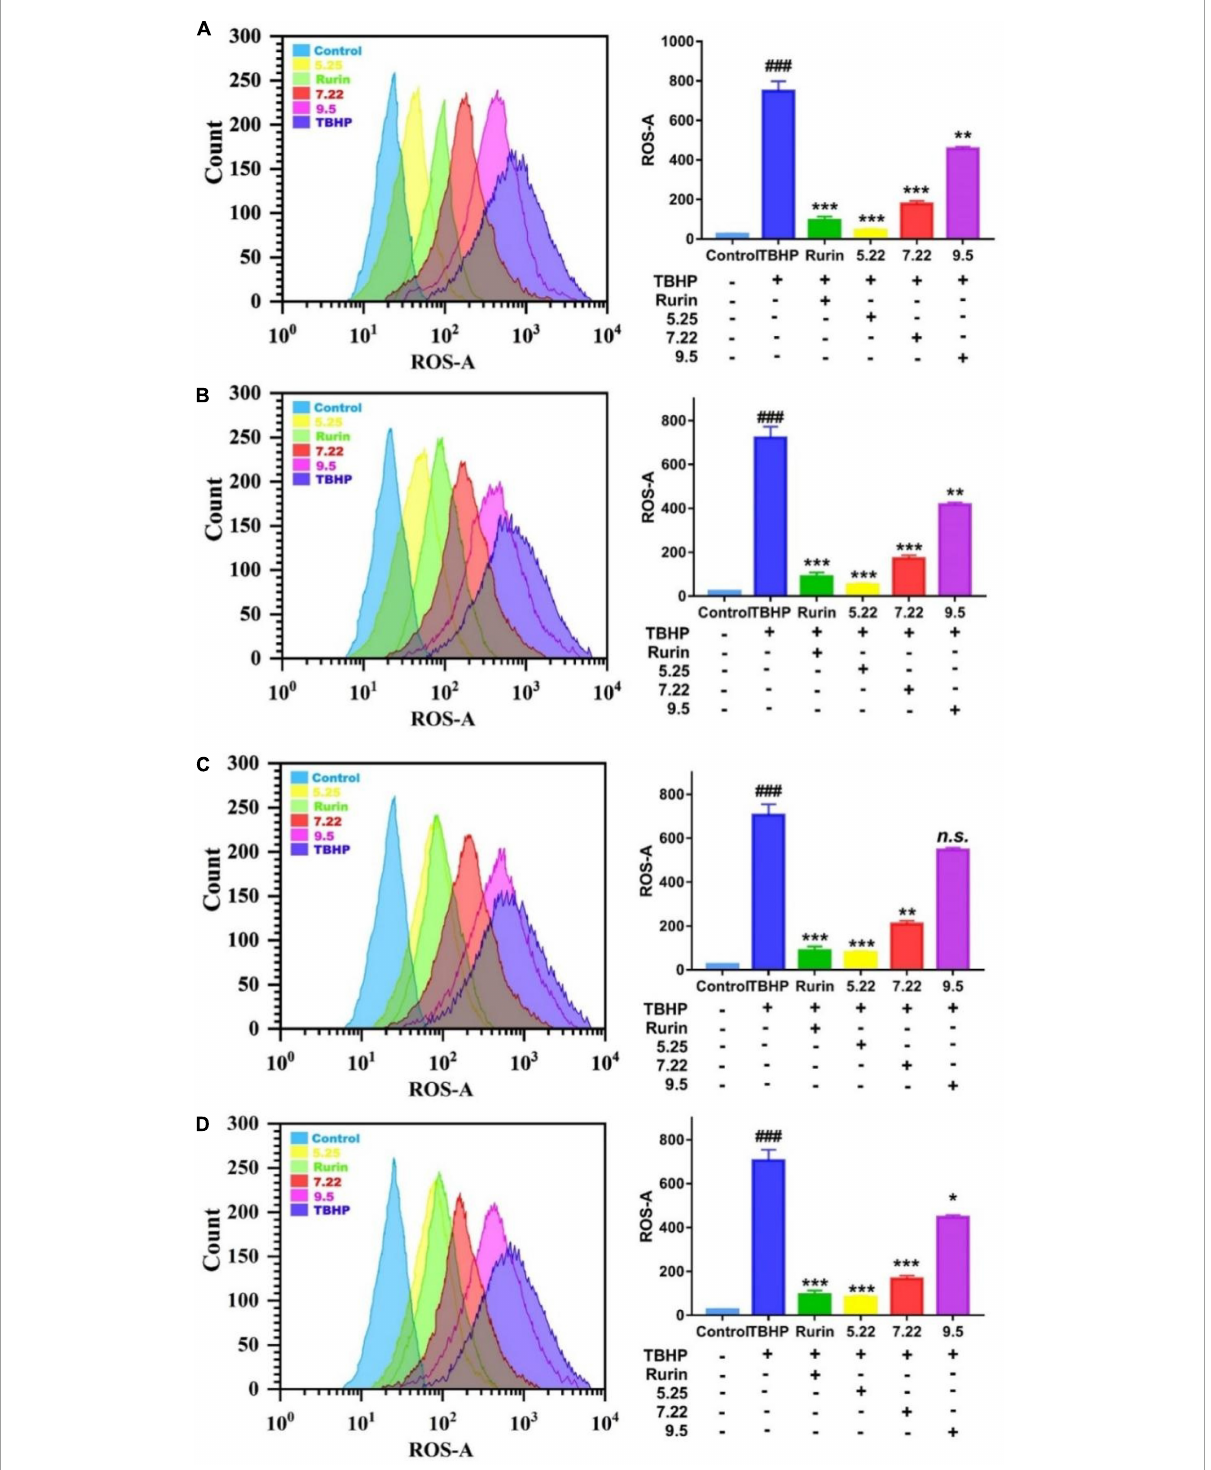
FIGURE7 Effect of nanguo pear (A) , Aksu Juju pear (B) , Hongxiang pear (C) and Luntai Juju pear (D) on ROS generation in TBHP-stimulated HEK-293 cell. Cells (0.8 mL, 1.0 × 10 6 CFU/mL) were treated with 200 mg/mL the extract of Nanguo pear, Aksu Juju pear, Hongxiang pear and Luntai Juju pear for 6 h, after 0.5 h of incubation with TBHP, were stained by DCFH-DA. The ROS levels in HEK-293 cell were determined and analyzed using flow cytometry. All data represent means ± SD of three independent experiments. ### p < 0.001, compared with control group, *** p < 0.001, ** p < 0.01 and * p < 0.05 related to TBHP